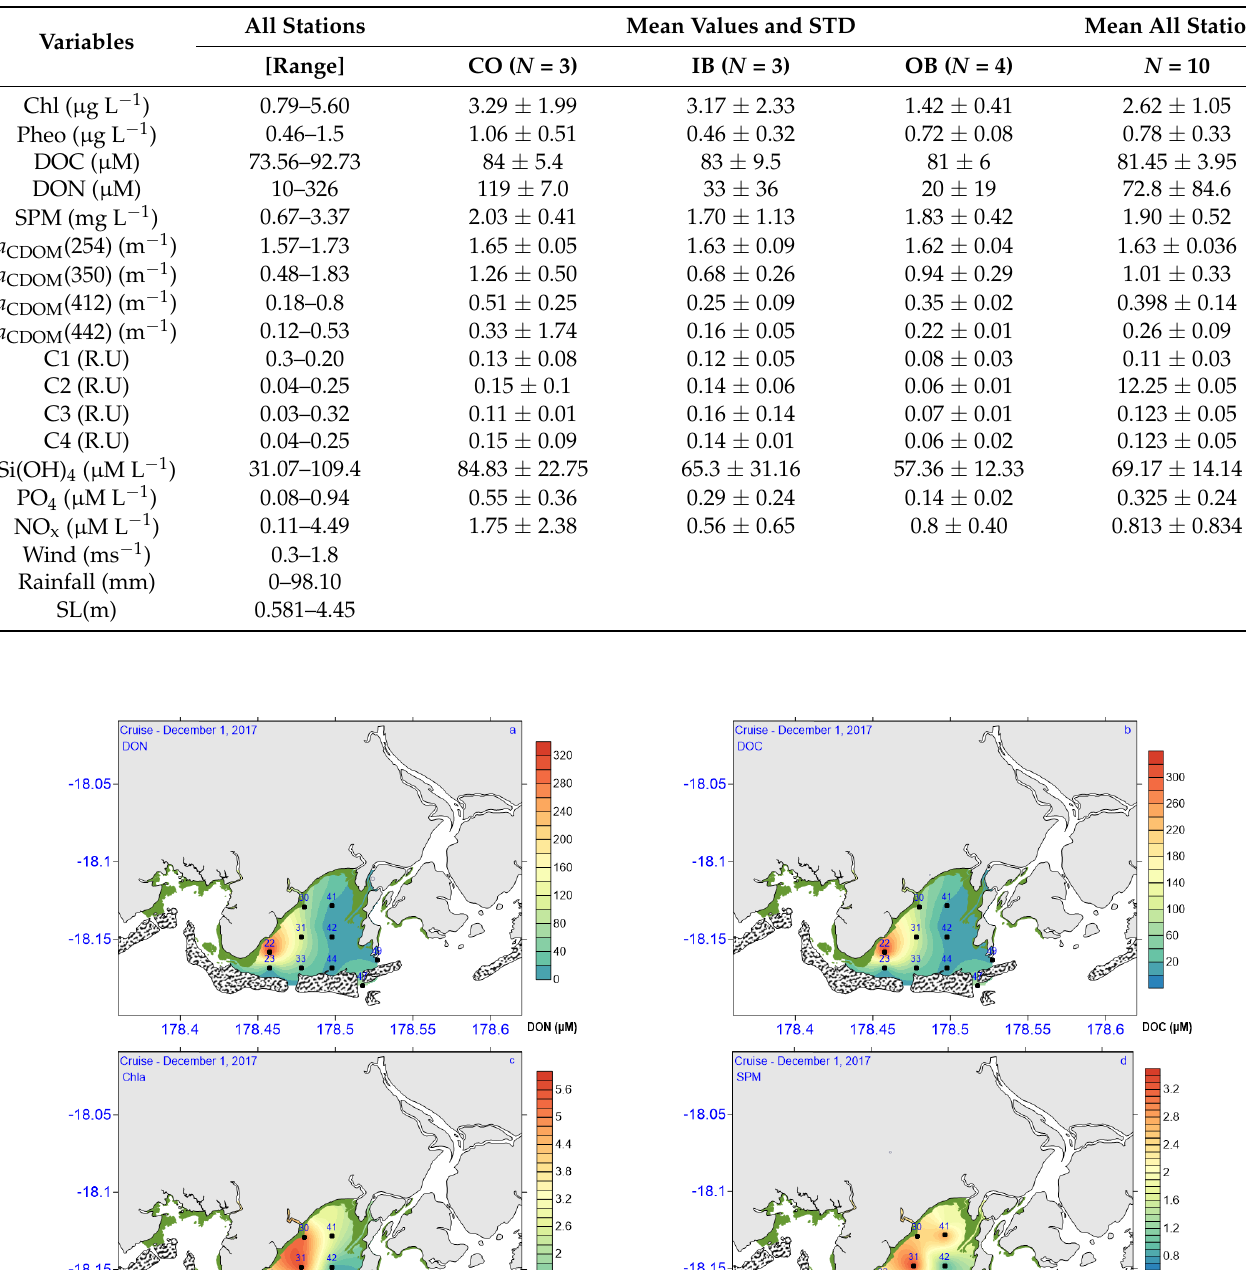
Table 3. Range, mean values, and standard deviations of the Biogeochemical and Nutrient variables for the CO, IB, and OB (for 10 stations).